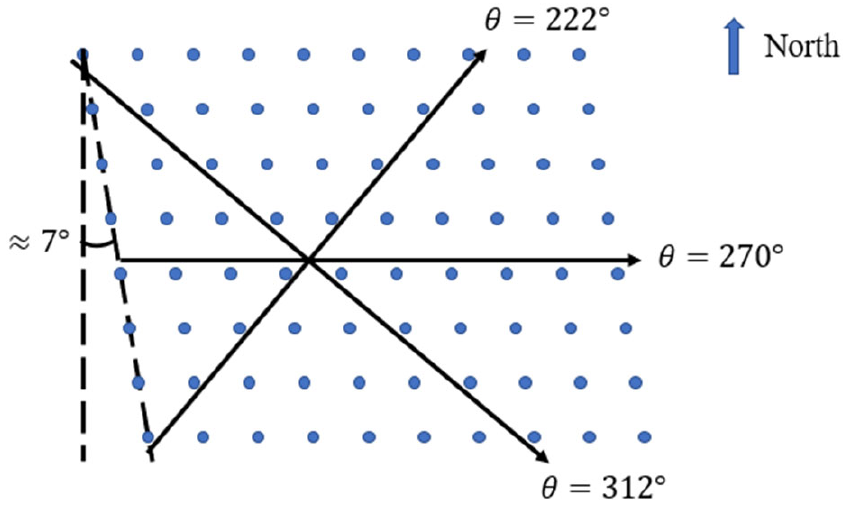
Figure 6. Wind turbine layout of the Horn Rev 1 wind farm. Table 6. Basic parameters of the wind turbine and operational conditions of the wind farm.